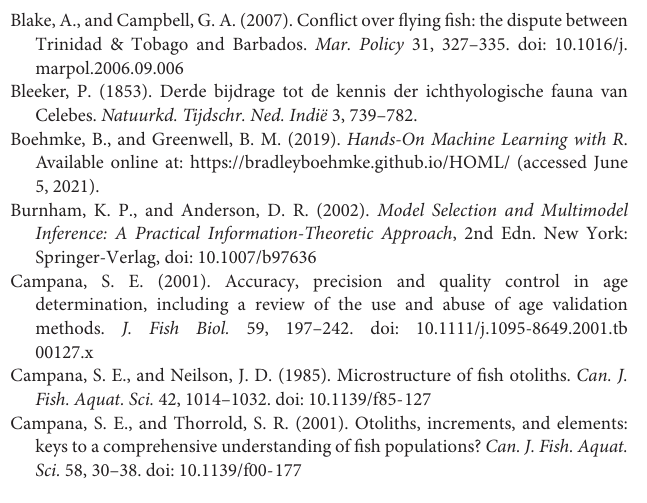
Supplementary Figure 1 | Images of otoliths (sagitta, lapillus, and asteriscus) of spotwing flyingfish (SPW), bony flyingfish (BNY), greater spotted flyingfish (GSP), and limpidwing flyingfish (LPW). The image of SPW is juvenile fish and the rest are adult fish. Supplementary Table 1 | Information on the estimates of growth parameters for flyingfishes by studies published